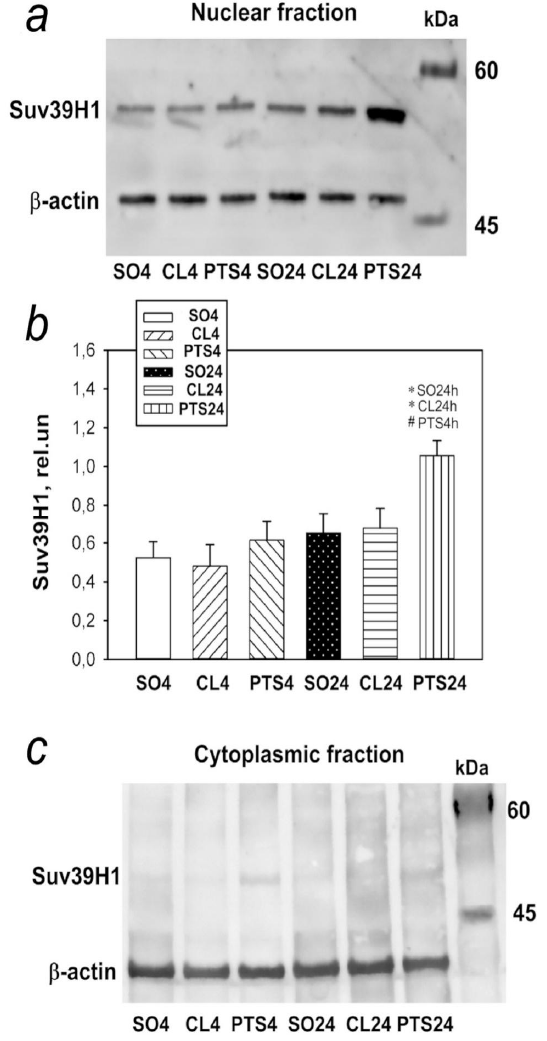
Figure 4. Suv39H1 expression in nuclear ( a , b ) and cytoplasmic ( c ) fractions of penumbra tissue at 4 and 24 h after photothrombotic stroke (PTS) in the rat cerebral cortex. The expression of Suv39H1 is shown at 4 and 24 h after PTS (PTS4